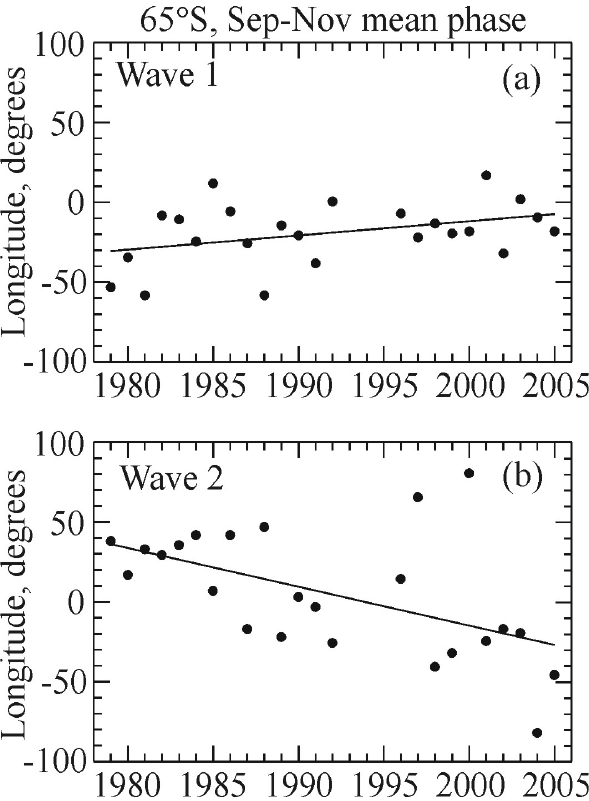
Fig. 9. Long-term change in the phase of (a) zonal wave 1 and (b) zonal wave 2 at 65 ◦ S.